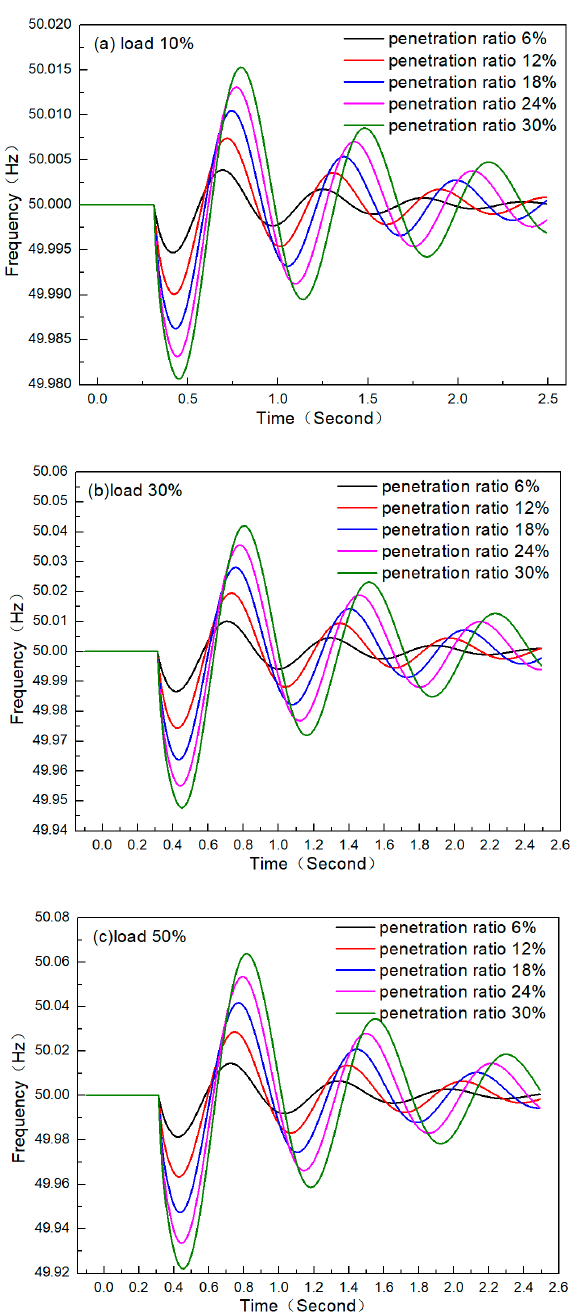
Figure 9. Influence of penetration rate and load change on grid frequency at nodes after PV storage: ( a ) load 10%; ( b ) load 30%; ( c ) load 50%.